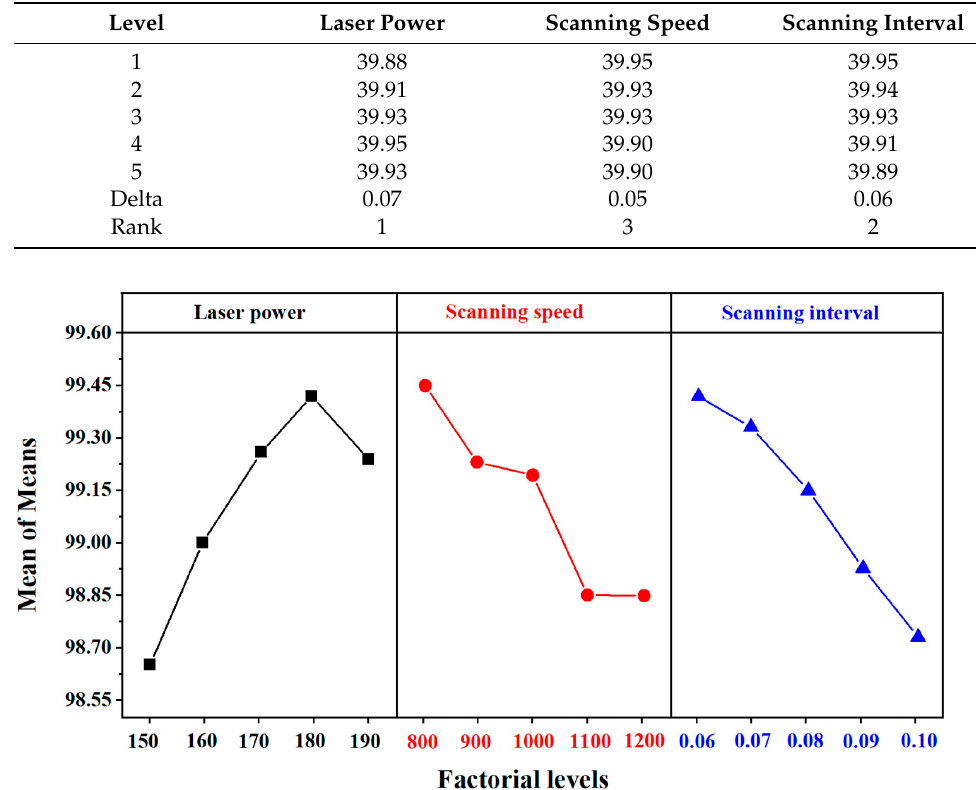
Table 5. S/N ratio response table for relative density.